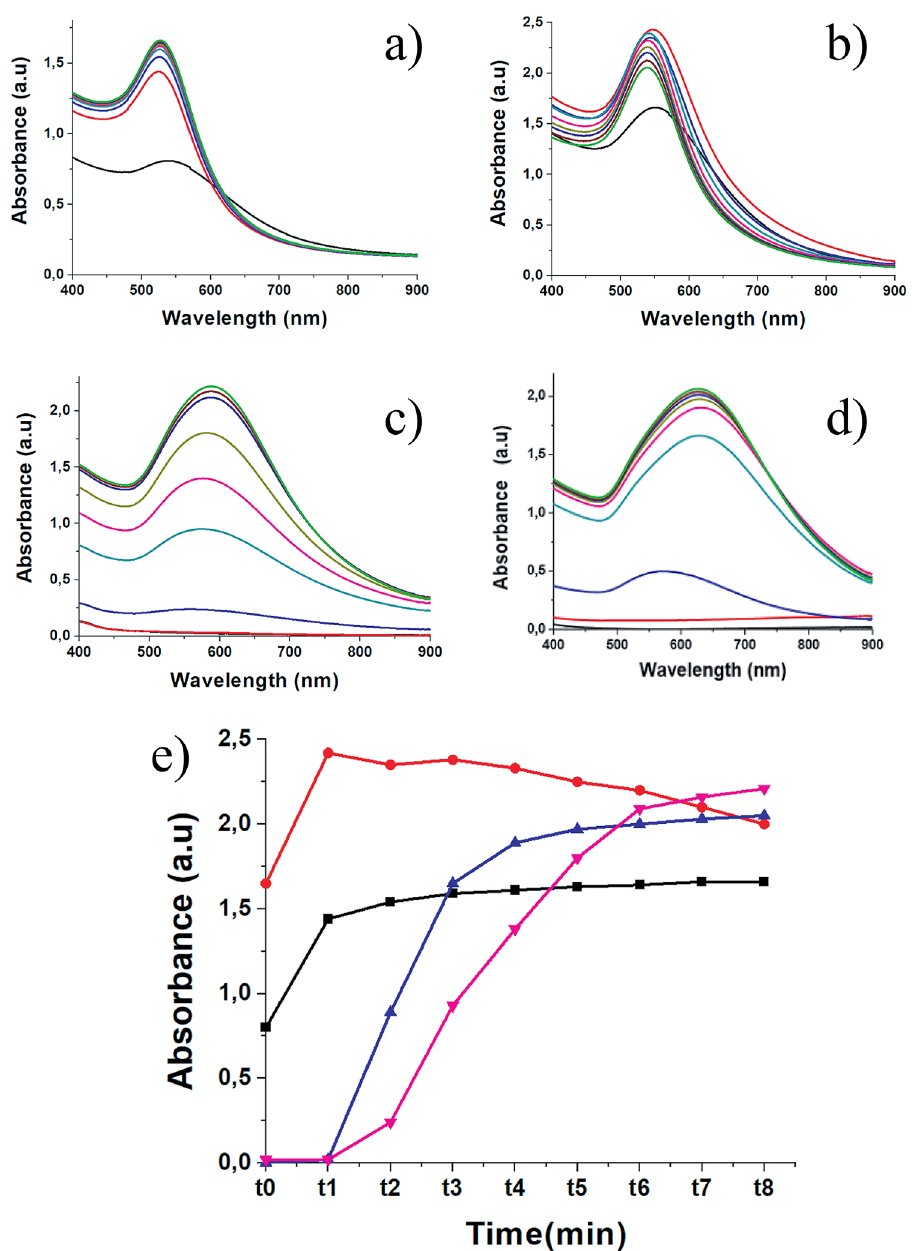
Figure 2. Plasmon monitoring. ( a – d ) UV–visible absorption spectra at different times of the synthesis of gold nanoparticles using HEPES ( a ), MnSOD ( b ), CAT ( c ) and BSA ( d ). The different colors correspond to different measurement times (black: t 0 , red: t 1 , blue: t 2 , green: t 3 , pink: t 4 , khaki: t 5 , dark blue: t 6 , brown: t 7 , dark pink: t 8 ), ( e ) evolution of the absorbance intensity in time for HEPES (black curve), MnSOD (red curve), CAT (pink curve) and BSA (blue